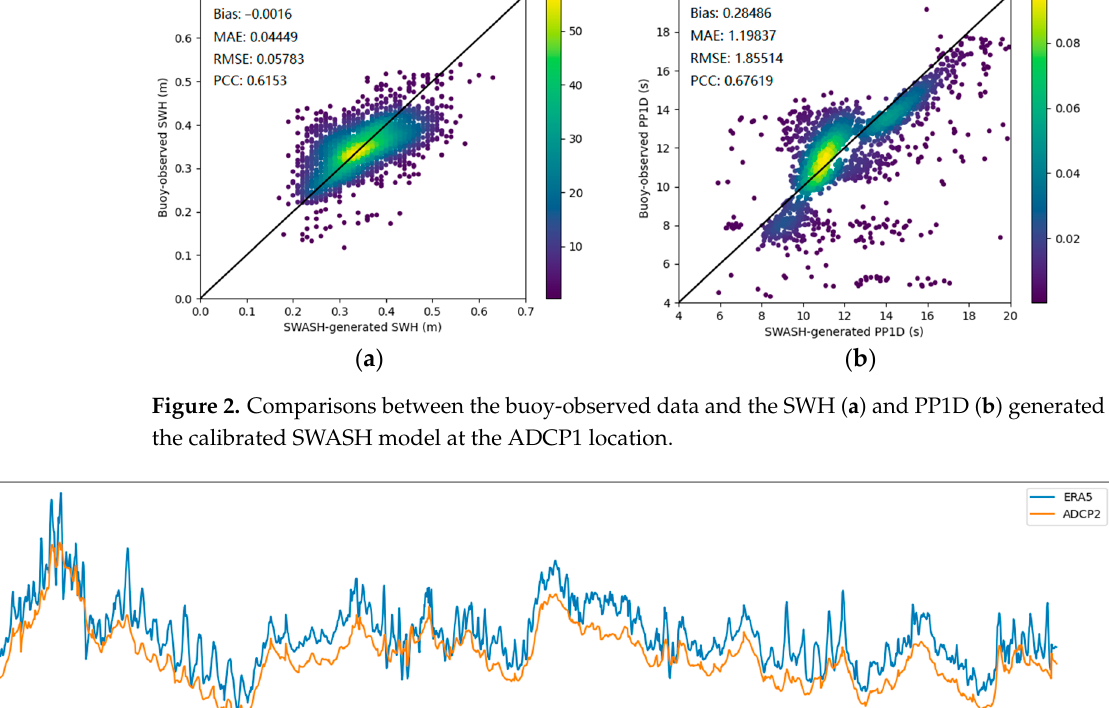
Figure 2. Comparisons between the buoy-observed data and the SWH ( a ) and PP1D ( b ) generated by the calibrated SWASH model at the ADCP1 location.